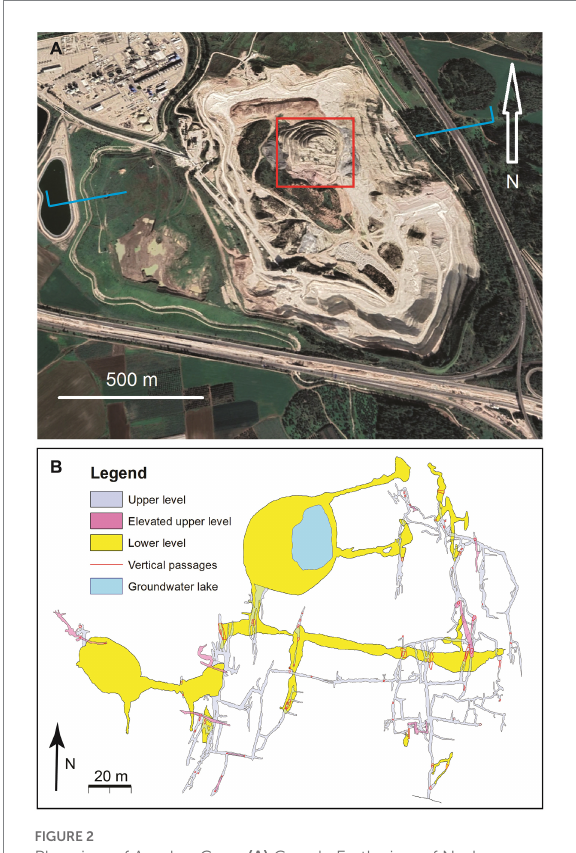
FIGURE 2 Plan view of Ayyalon Cave. (A) Google Earth view of Nesher- Ramla quarry with the central quarried ‘hill’ preserving the cave. Blue tags indicate general location of Figure 1C. (B) Ayyalon Cave plan, with 2.7 km long passages in three levels, vertical phreatic shafts indicating past rising water, and the groundwater pond where the ecosystem is centered.